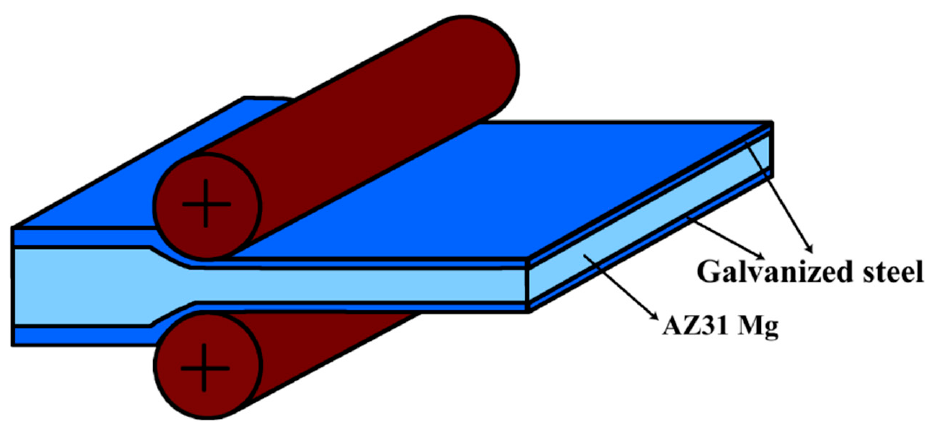
Figure 1. Schematic of the roll cladding of a multilayer composite sheet.